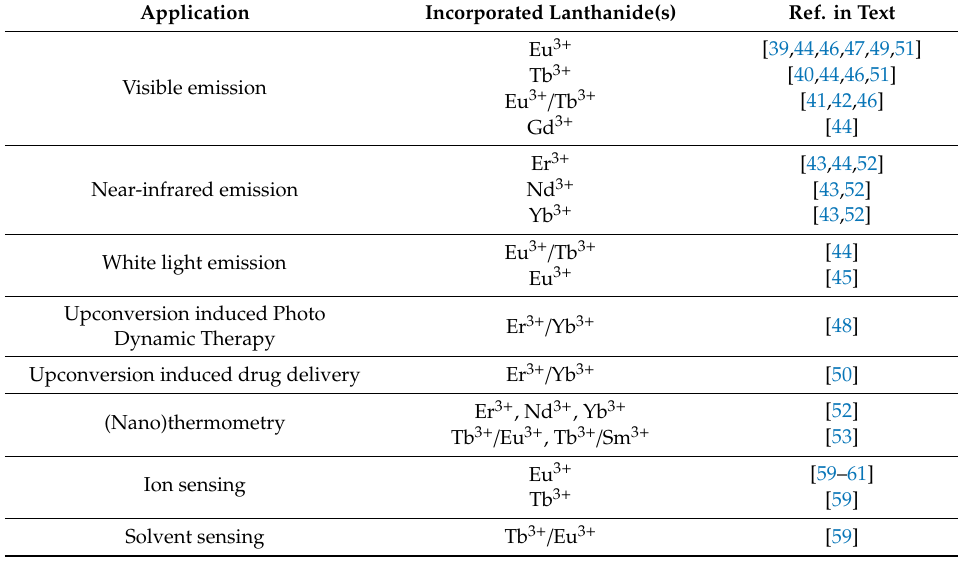
Figure 12. Overview of selected PMO precursors used for the formation of LnPMOs. The reference to the appropriate publication is given under the precursor structure. Table 2. Summary of the proposed applications for the LnPMO materials.